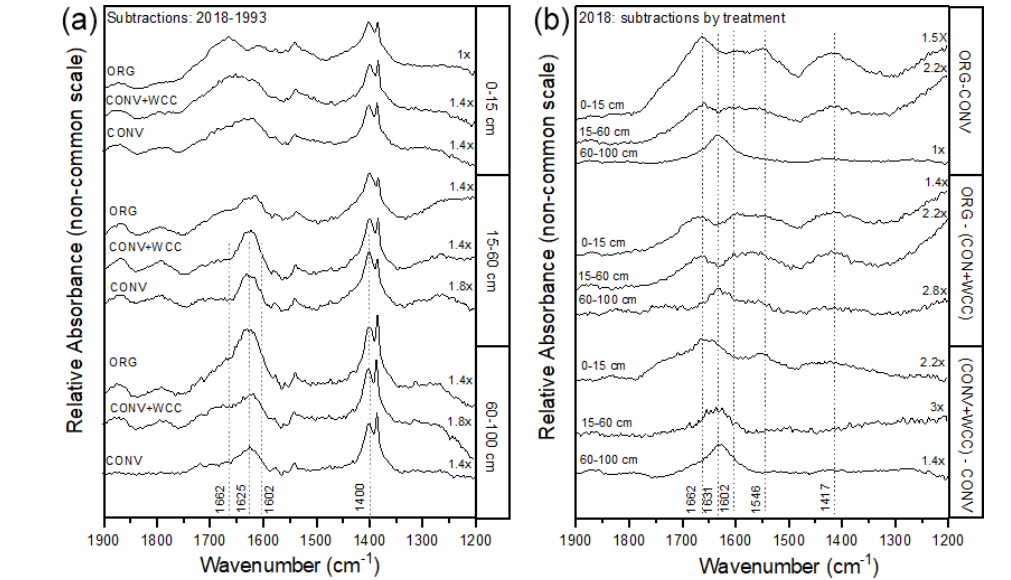
Figure A4. (a, b) FTIR spectral subtractions for the 1900–1200cm − 1 range comparing (a) 2018–1993 spectra for ORG, CONV + WCC, and CONV and (b) ORG, CONV + WCC, and CONV spectra in 2018.